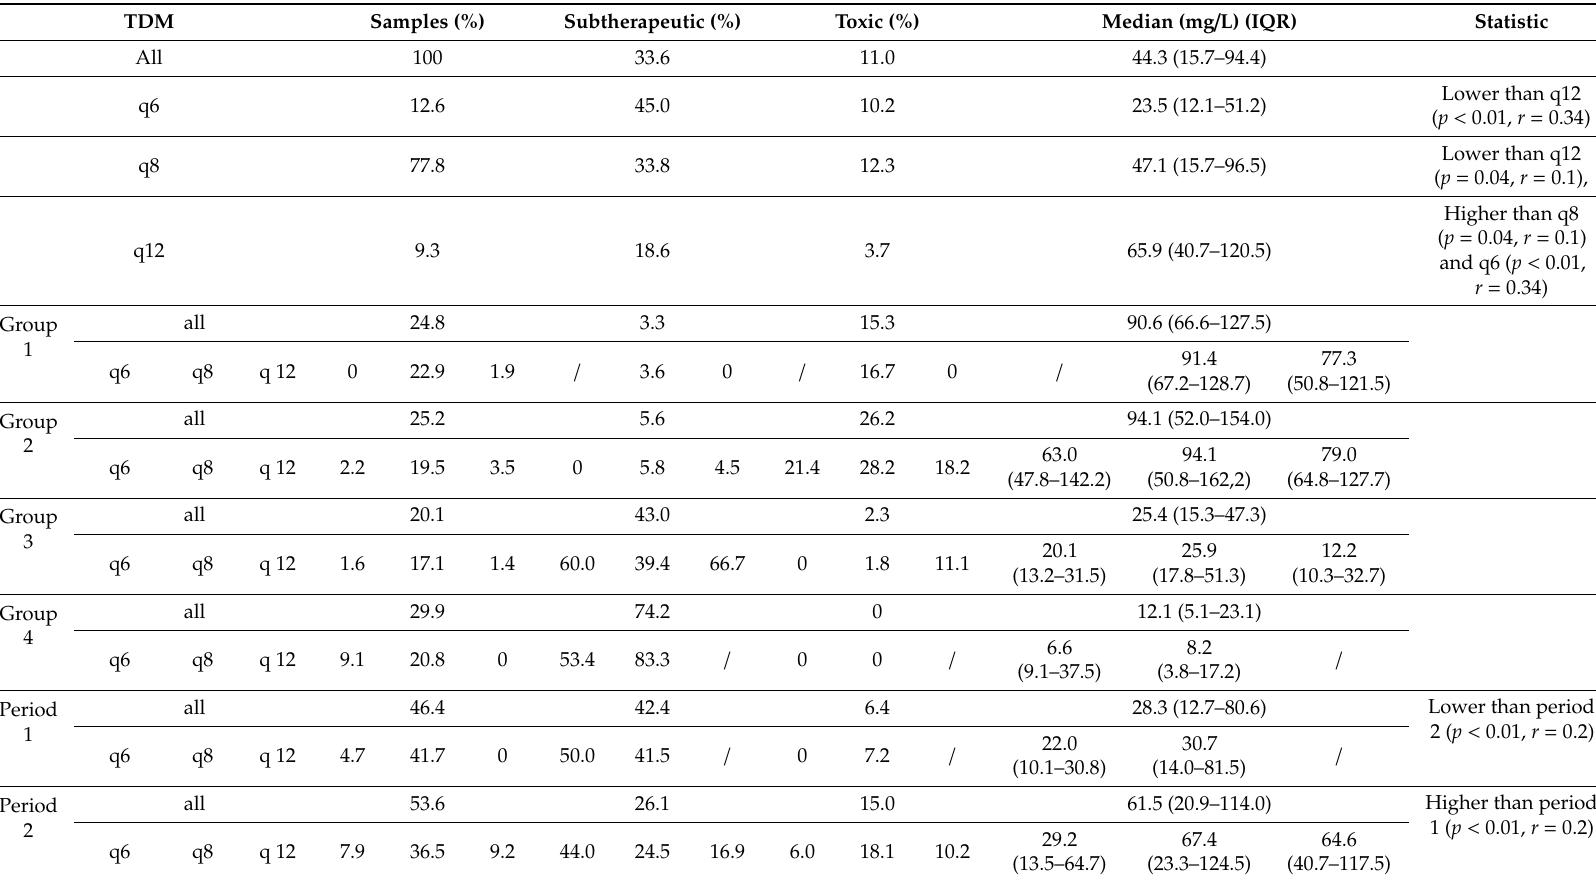
Table 3. Piperacillin dosing, piperacillin concentration based on renal function, and statistical di ff erences in di ff erent